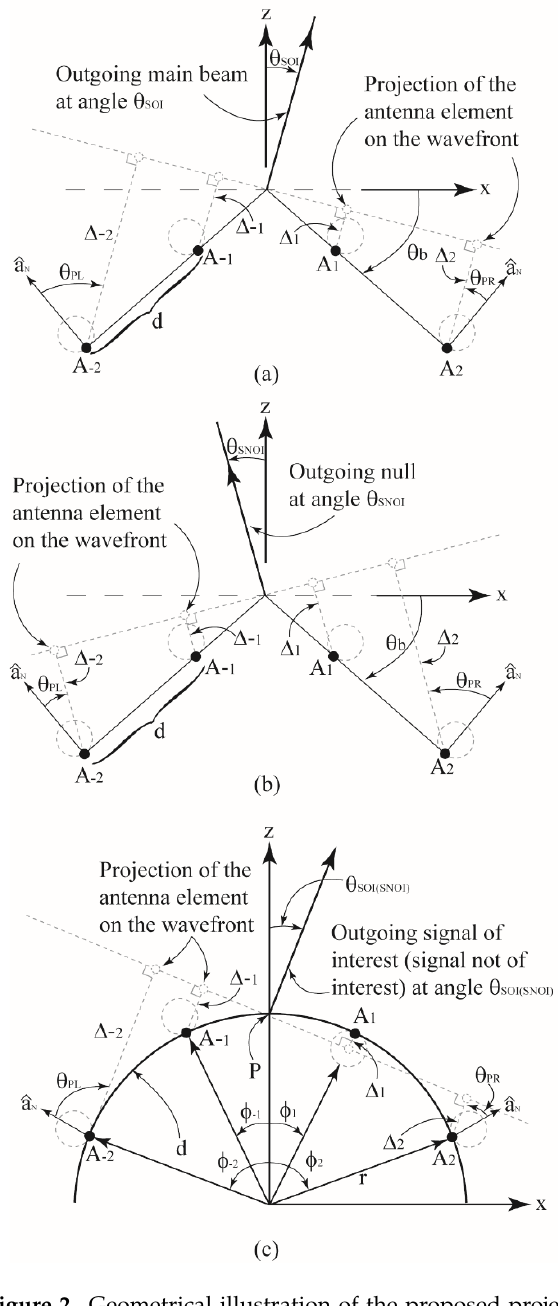
Figure 2. Geometrical illustration of the proposed projection method for ( a ) antenna array on a wedged-shaped surface with desired signal at angle θ SOI ; ( b ) antenna array on a wedged-shaped surface with undesired signal at angle θ SNOI and ( c ) antenna array on a cylindrical curvature with desired (undesired) signal at angle θ SOI(SNOI) To compute the surface-dependent array weights, the projection method [31] will be used along with the matrix method for computing antenna weights defined in [1]. Since a maximum radiation in the direction of 𝜃 (cid:3020)(cid:3016)(cid:3010) and nulls in the directions of 𝜃 (cid:3020)(cid:3015)(cid:3016)(cid:3010) are desired, the array will be considered as a transmitter. First, suppose the and 𝜃 (cid:3020)(cid:3015)(cid:3016)(cid:3010) (cid:3119) antenna array is radiating in the direction of 𝜃 (cid:3020)(cid:3016)(cid:3010) , as shown in Figure 2a. One method used to provide a field in the direction of 𝜃 (cid:3020)(cid:3016)(cid:3010) is to ensure that the fields radiated from